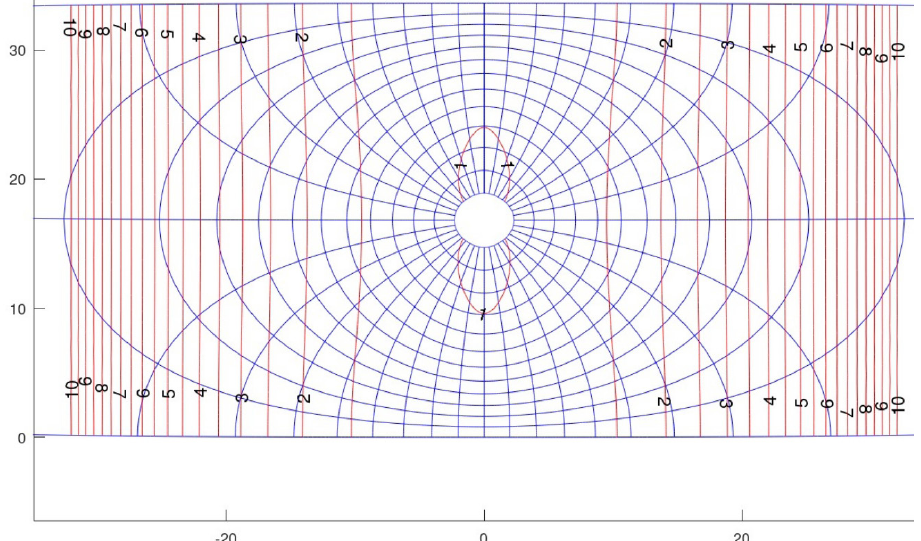
Fig. 13. The cartographic grid and the distribution of distortions in the Gauss-Schreiber projection